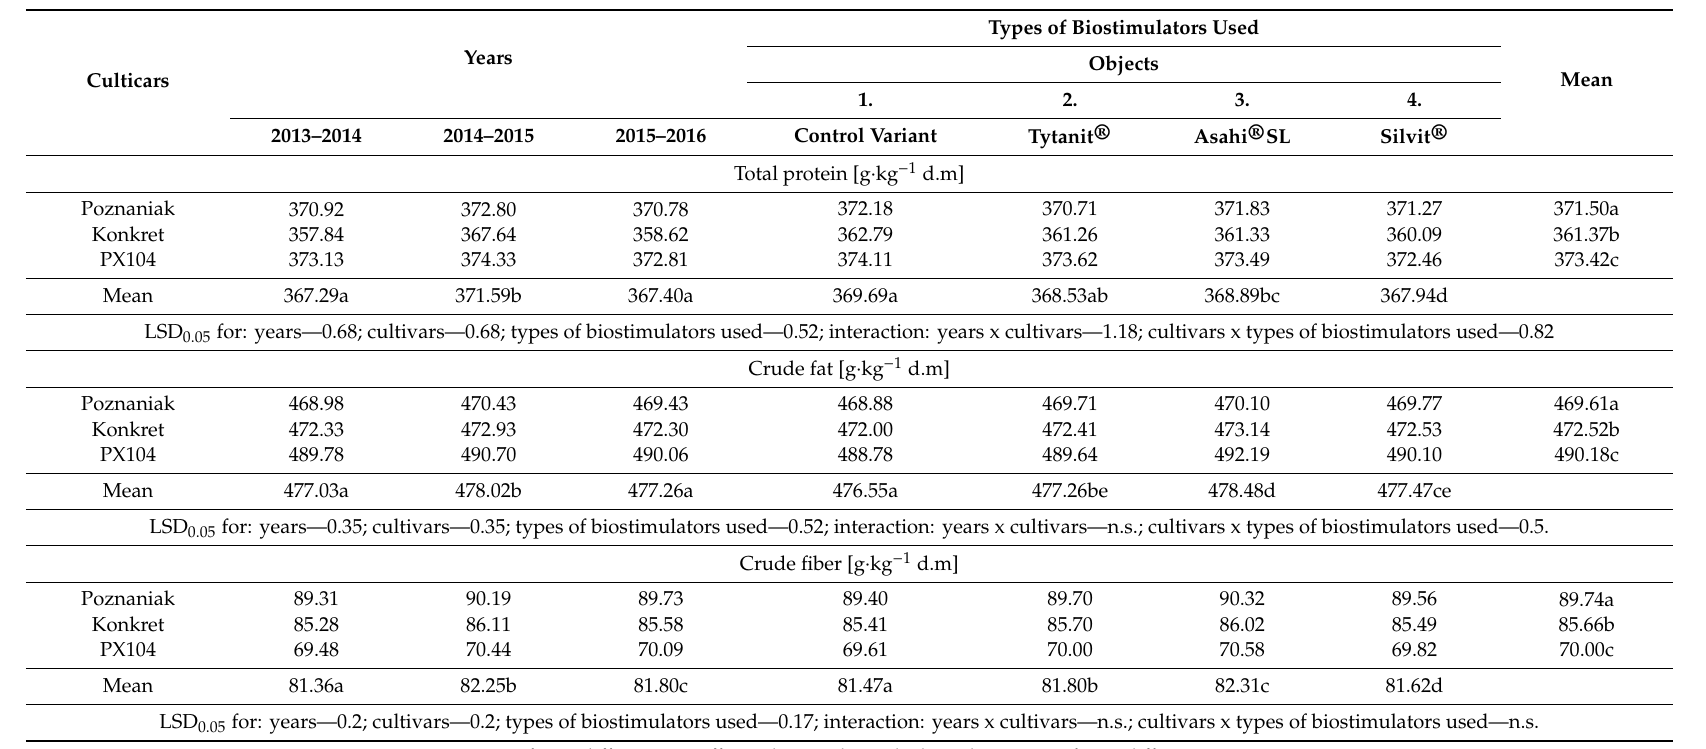
n.s.—non-significant di ff erences. Di ff erent letters above the bars denote significant di ff erences p ≤